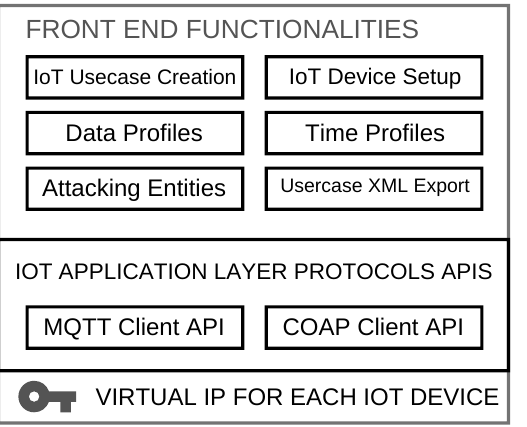
Figure 2. Basic architecture of the IoT-Flock [16,24] tool developed for IoT traffic